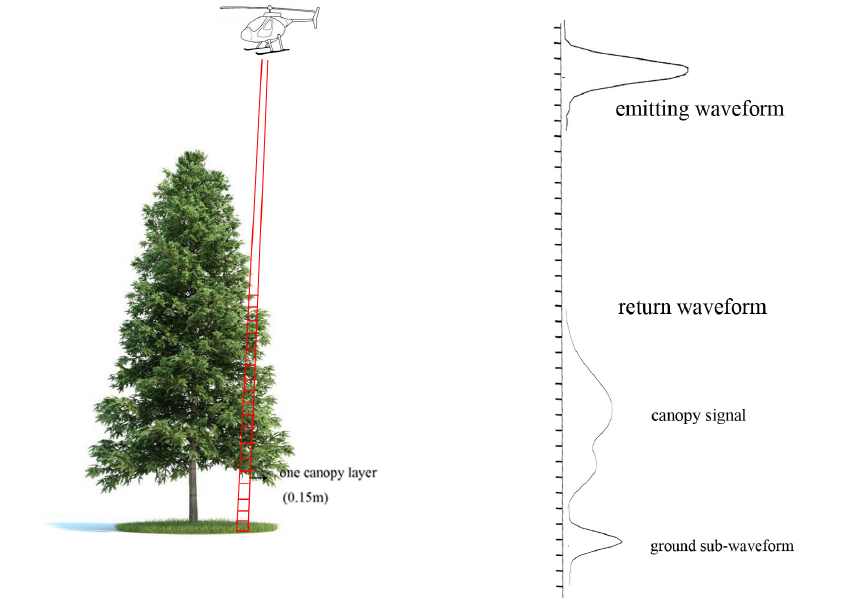
Figure 1. Basic process of the Light Detection And Ranging (LiDAR)–forest interaction.